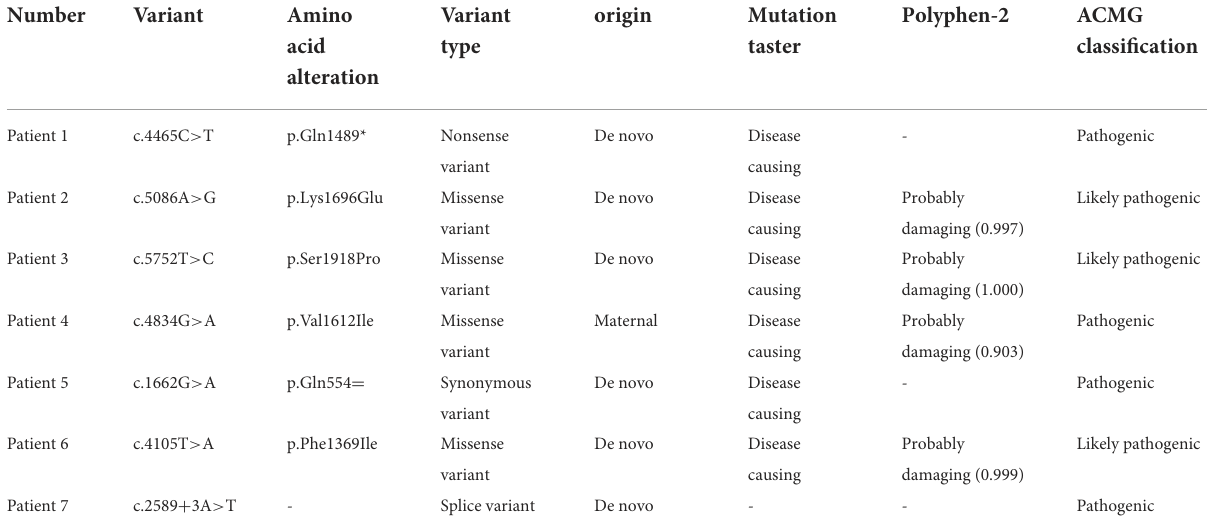
TABLE 2 Analysis of SCN1A variants of seven patients. (NM_001165963.4). Number